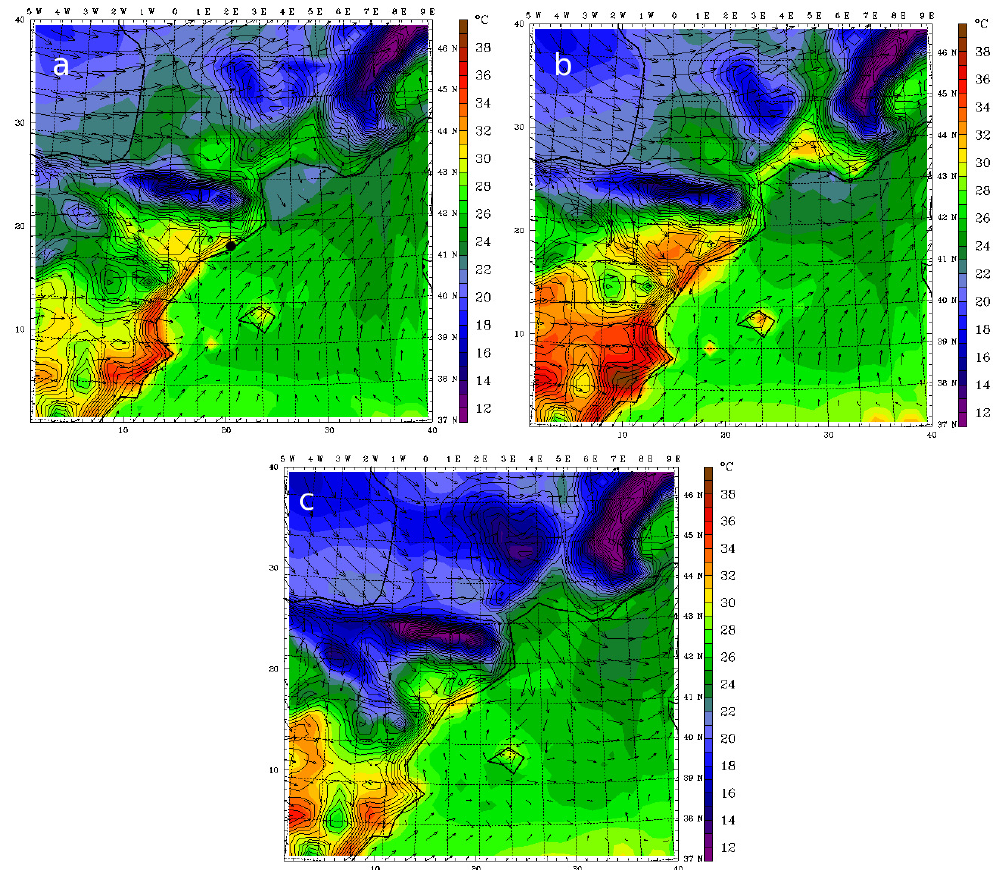
Fig. 3. Simulated 2– m temperature (color contour) and surface wind field (arrows) at domain 1 at (a) 10:00, (b) 15:00 and (c) 18:00 UTC on 27 August 2010. The black point in (a) indicates the location of Barcelona.